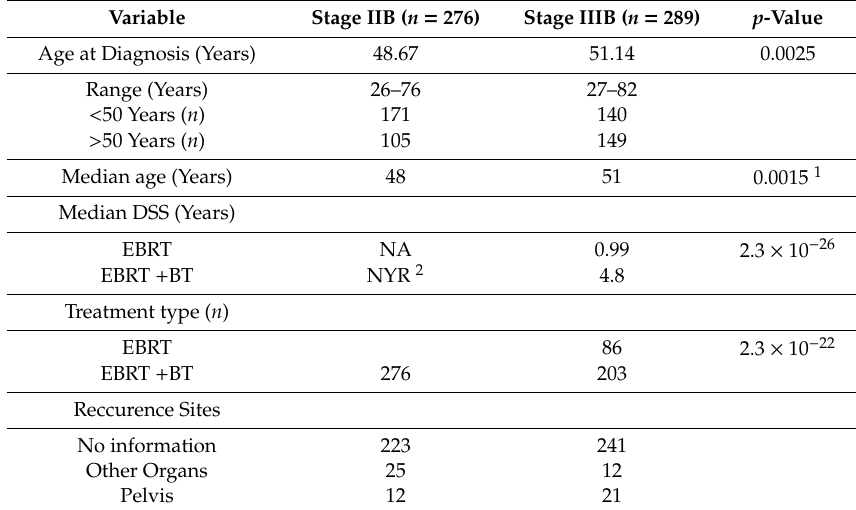
Table 1. Clinical and demographic variables for subjects with squamous cell carcinoma of cervix ( n = 565) recruited in Cervicusco